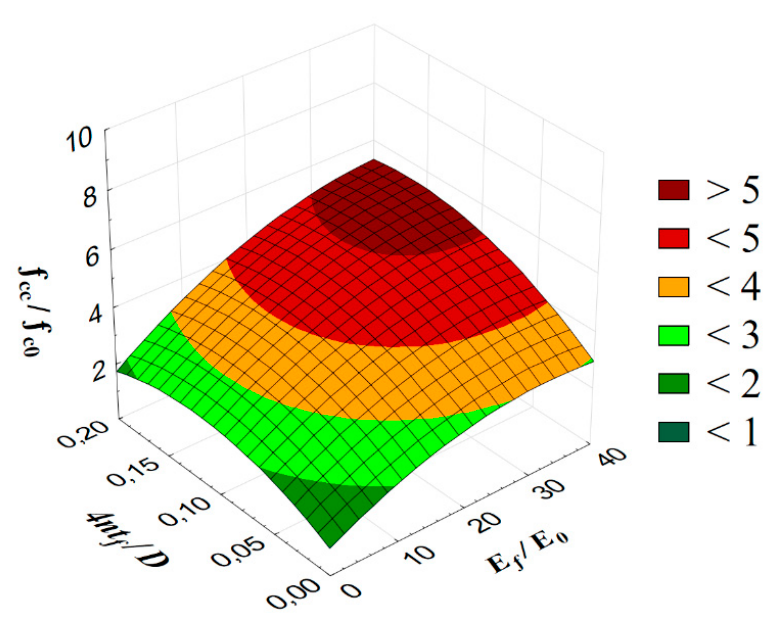
Figure 1. Color map of the effectiveness of the FRP-confinement of concrete.